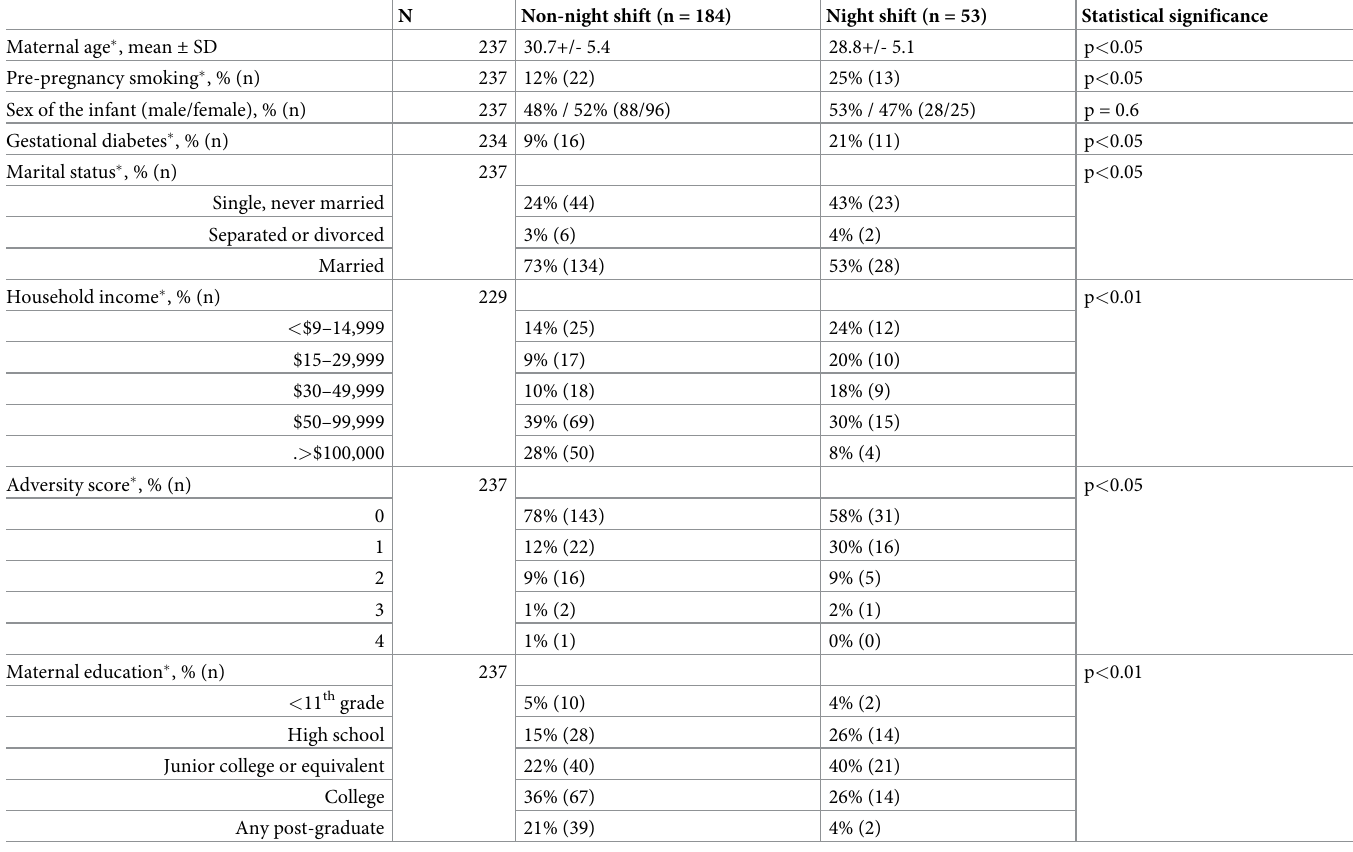
Table 1. Demographic characteristics of participants included in the analysis (n = 237) by night shift work status.